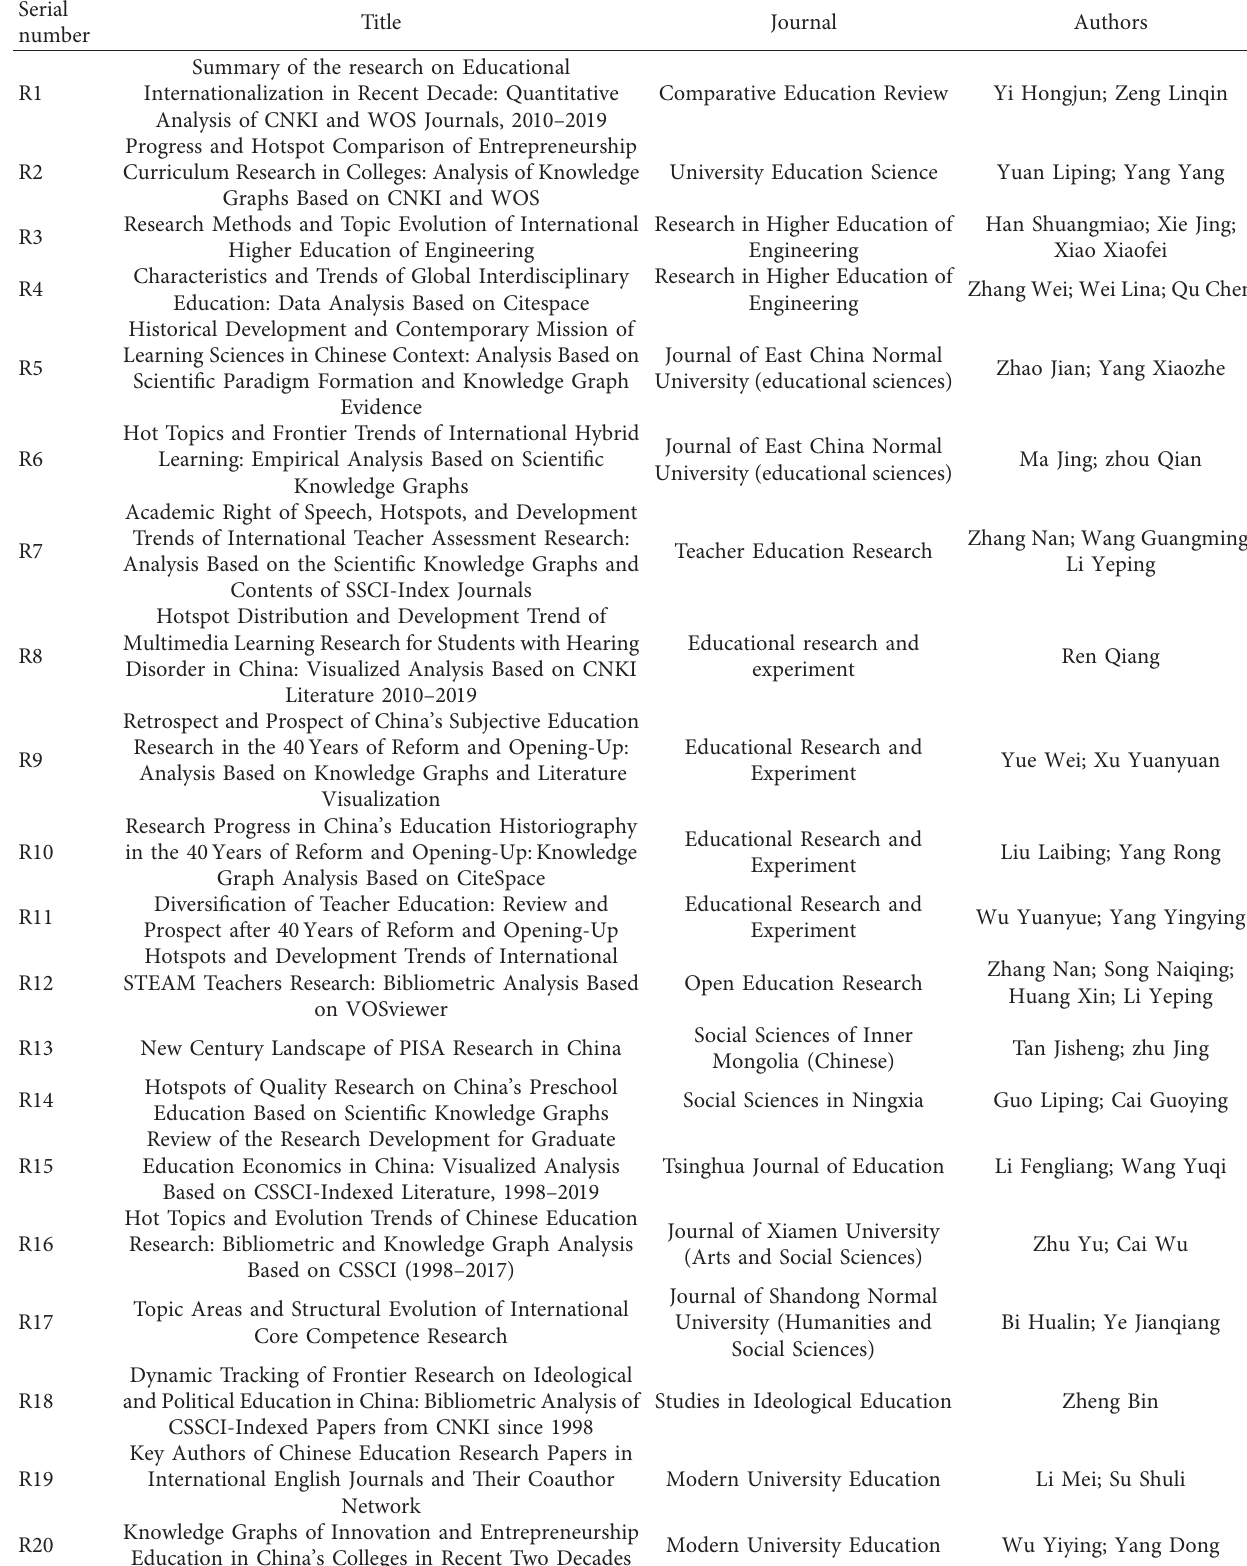
Table 3: Papers on knowledge graph applications in education 2019–2020 from CSSCI